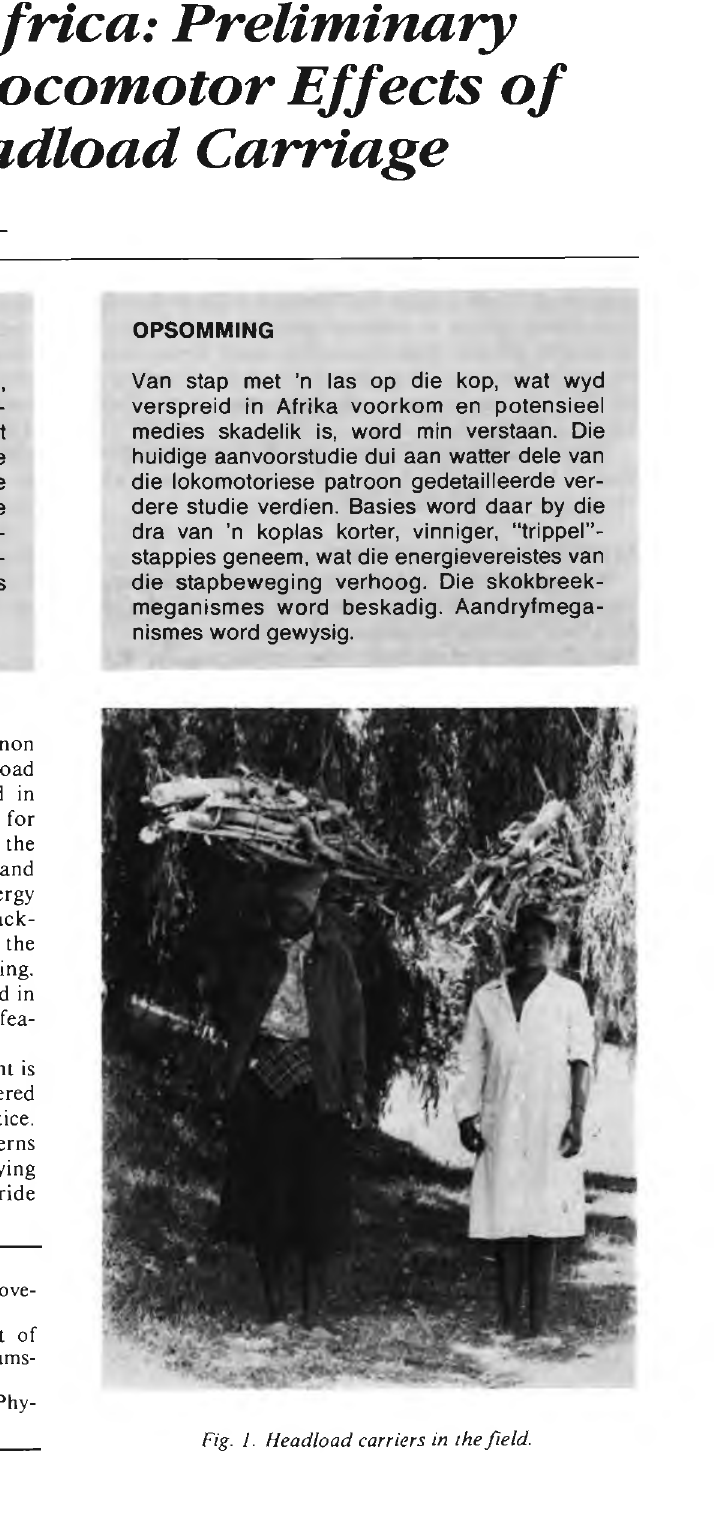
Fig. I. Headload carriers in the